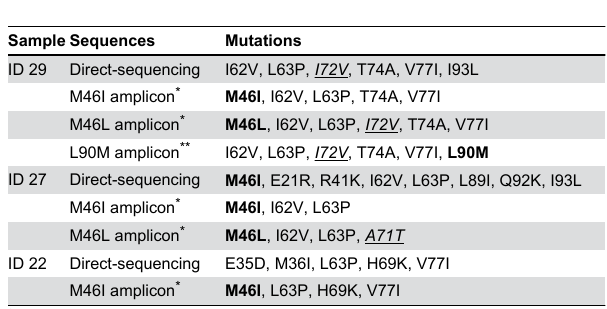
Table 3. Genetic linkage of M46I/L or L90M and other mutations.